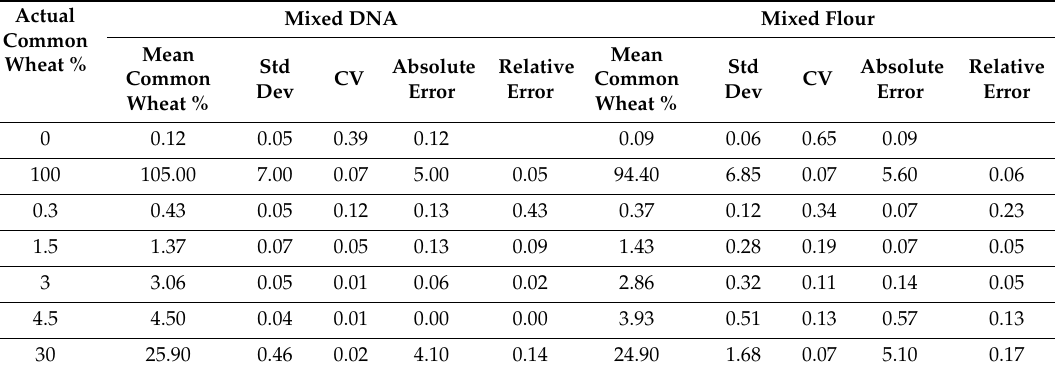
Table 2. Actual common wheat percentages in comparison with those experimentally determined in two di ff erent classes of samples. “Mixed DNA” samples were obtained by mixing DNA extracted from pure common and durum wheat species. “Mixed flour” samples were obtained by extracting DNA from of common and durum wheat flours mixed at di ff erent percentages). CV: Coe ffi cient of